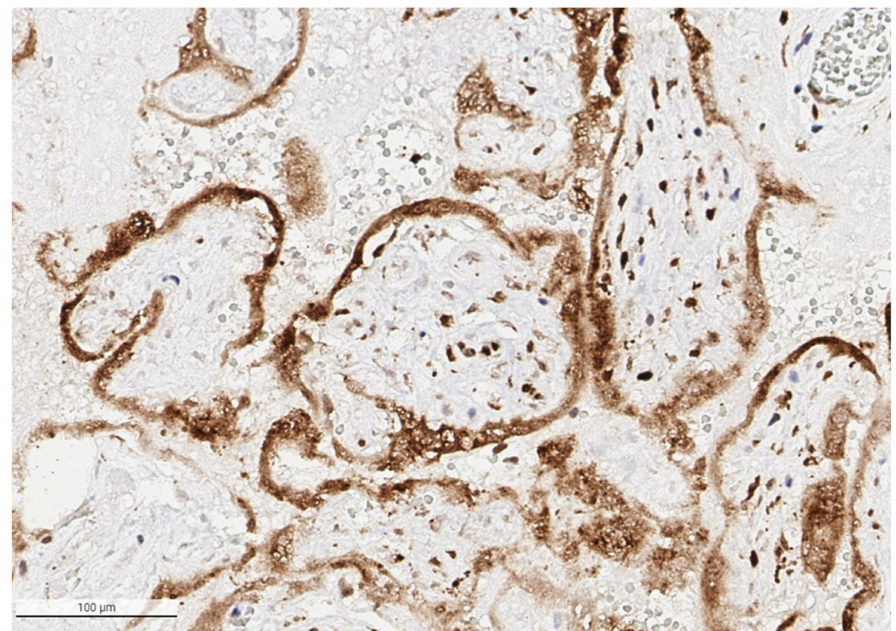
Figure 6. The syncytiotrophoblast is strongly positive for SARS-CoV-2 antigen in the placenta from a stillborn fetus delivered at 35 weeks 4 days to a mother with COVID-19 infection. Cells in the villous stroma can also be seen as staining positive for the virus. Antibody to SARS-CoV-2 spike protein, ×